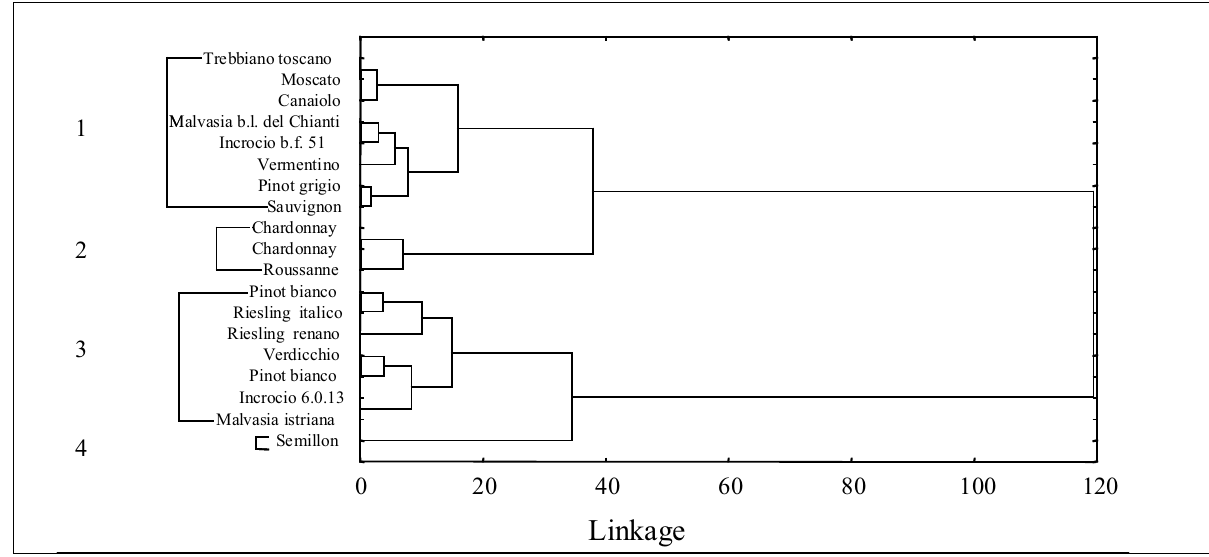
3. Horizontal hierarchical tree plot of the 17 white-grape cultivars grown in vineyard CBSI-3. Amalgamation was determined on the number of healthy plants and esca-infected plants counted for each cultivar in 1999 at the end of the five-year inspection period. The cultivars Pinot bianco and Chardonnay were planted on two columns. The figure shows 4 clusters (identified as 1-4) which represent a possible grouping of the cultivars by their suscep- tibility to